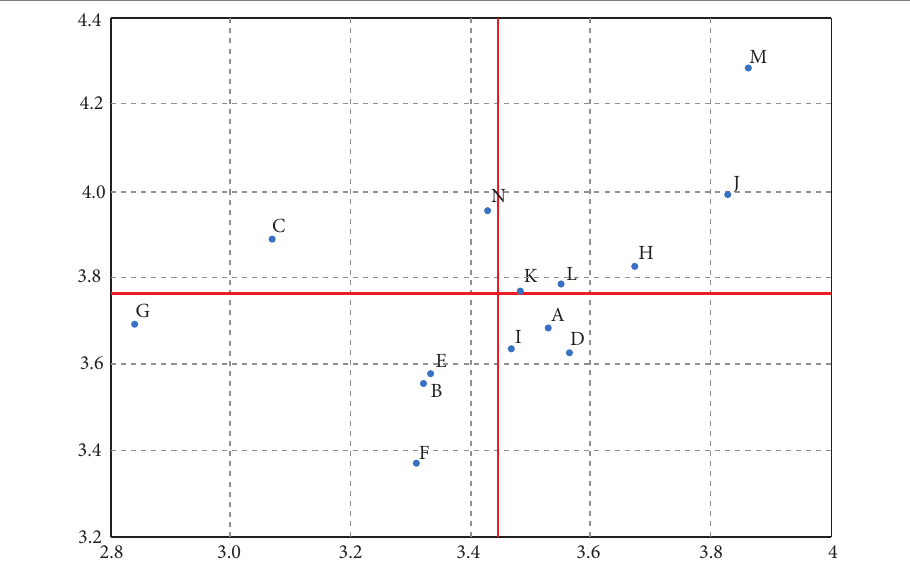
Fig. 8. The scatter diagram of parameters of relations of Polish enterprises with the investor/investor’s